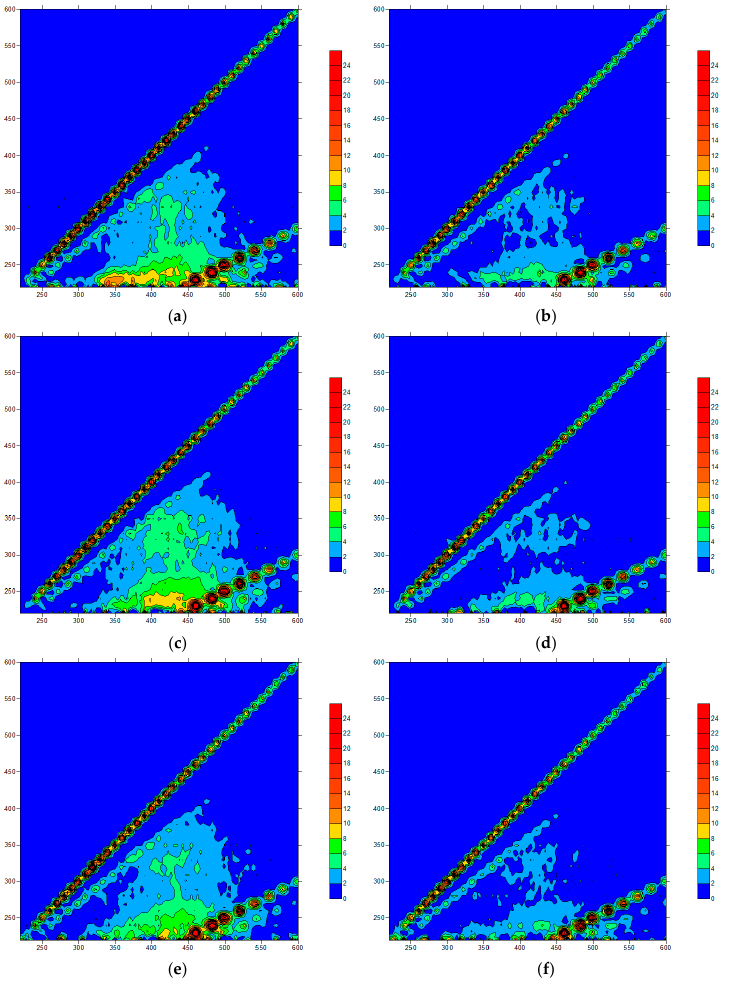
Figure 7. Fluorescence spectra of an O 3 pre-oxidation effluent: ( a ) 0.5 mg/L; ( b ) 0.5 mg/L + PAC; ( c ) 1.0 mg/L; ( d ) 1.0 mg/L + PAC; ( e ) 1.5 mg/L; ( f ) 1.5 mg/L + PAC.